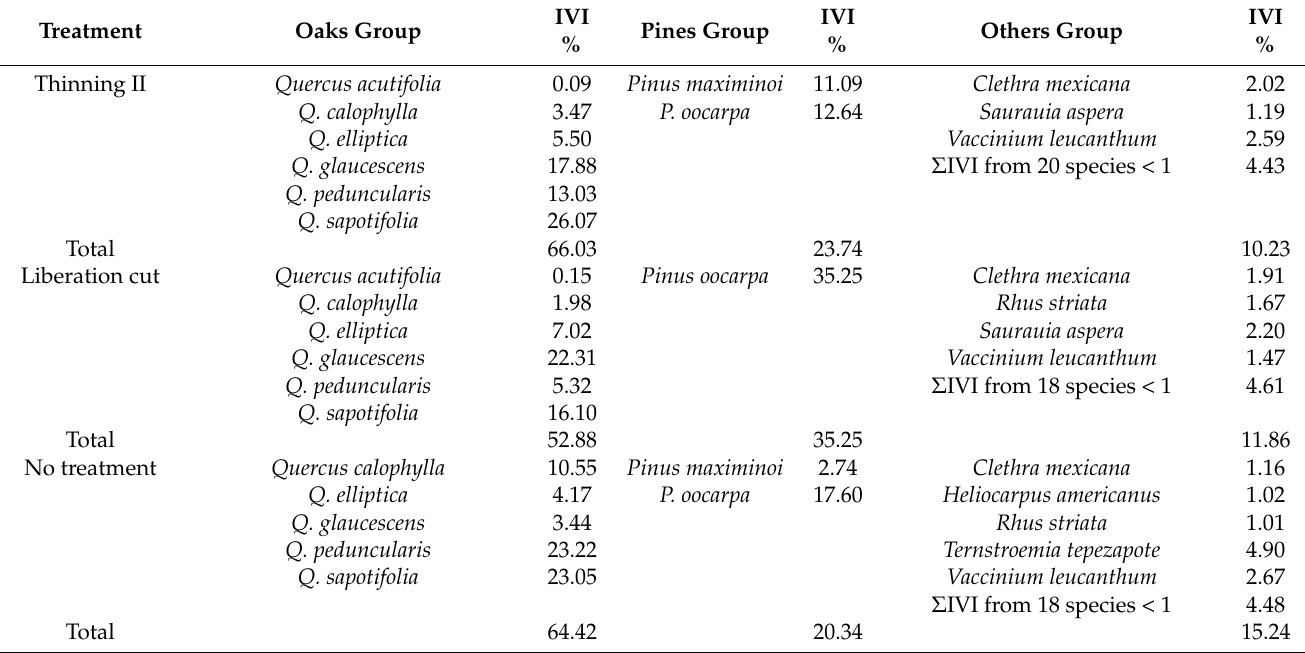
Table 3. Importance value index (IVI) for the dominant species recorded under silvicultural treatments in the Ocotones forest, Chiapas, Mexico. Other species with an IVI of less than 1% can be found in Table S3.